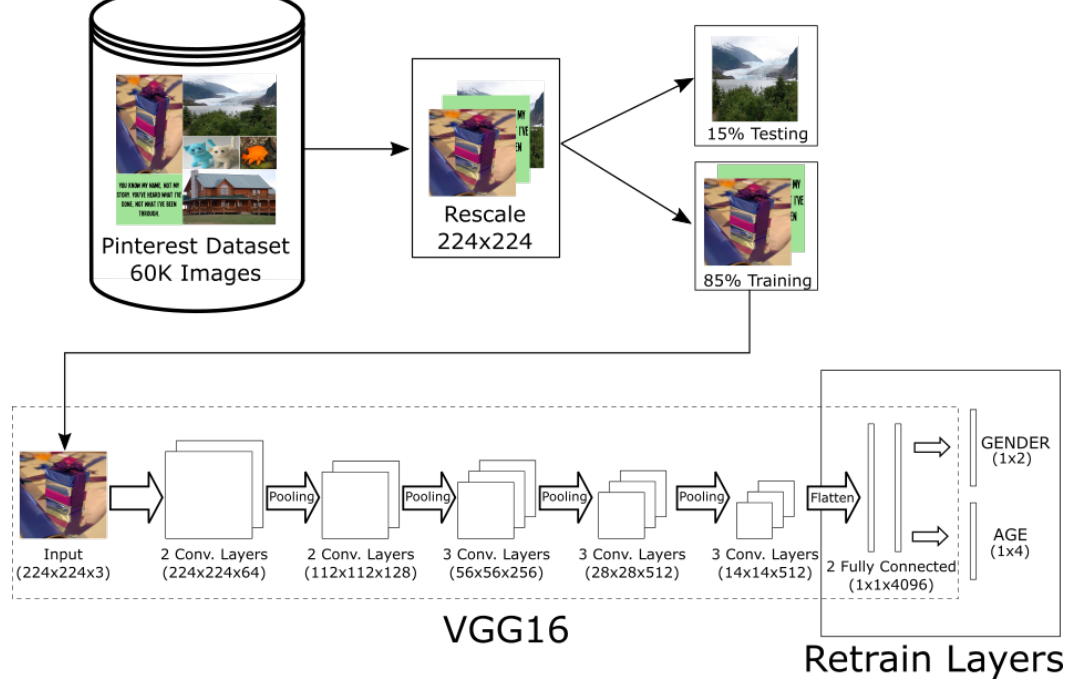
Figure 1. General Methodology using images.